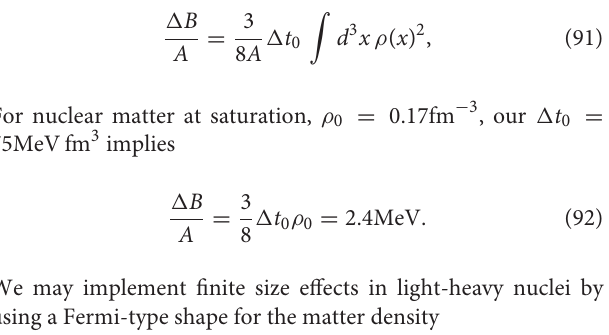
TABLE 13 | Moshinsky-Skyrme parameters for the renormalization scale 3